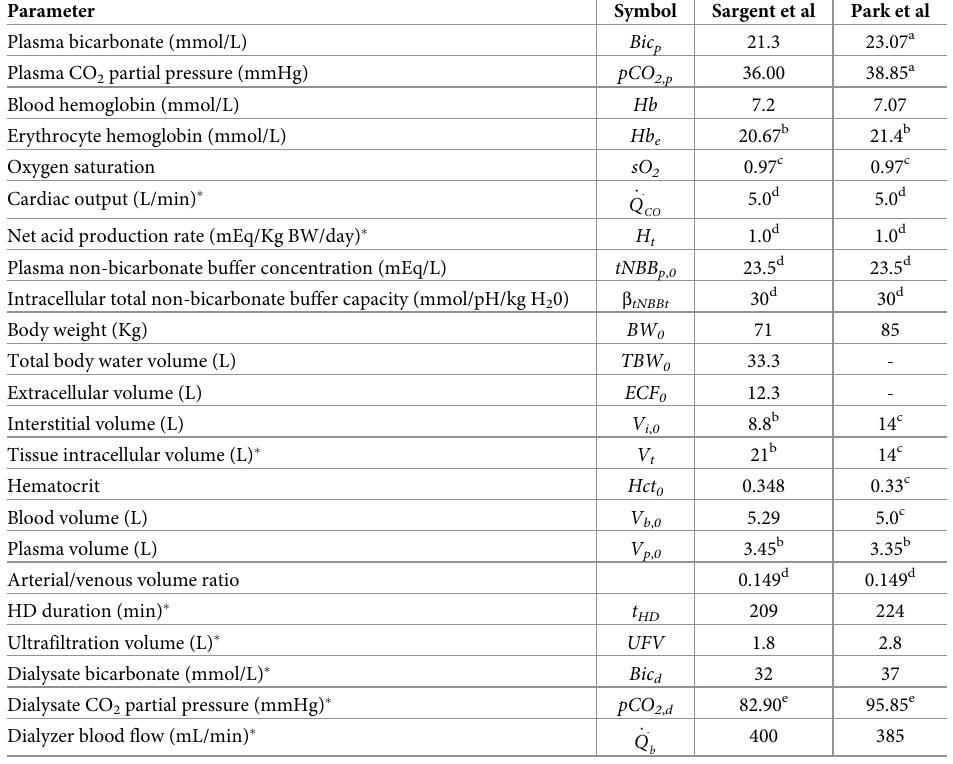
Table 1. Patient-specific and treatment-specific parameters for the two clinical studies [26,31]to which the model was applied. The values used here are the average of the data reported. For patient-specific parameters, initial values are reported unless otherwise specified. Measurements missing in the datasets were taken from the original description of the model or assumed based on standard values for the patient population.